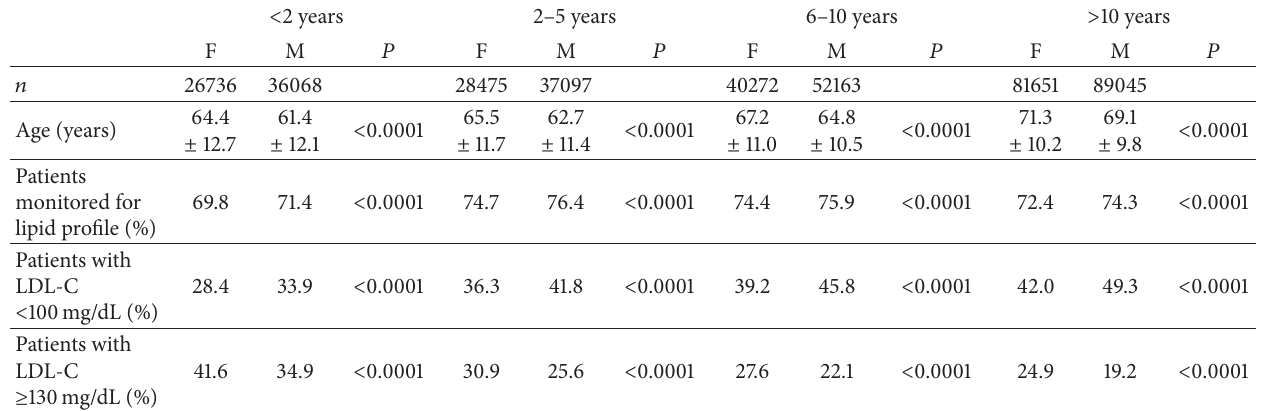
Data are 𝑛 , %, and means ± standard deviation. Table 4: Age-adjusted and diabetes duration-adjusted indicators of quality of LDL-C management according to